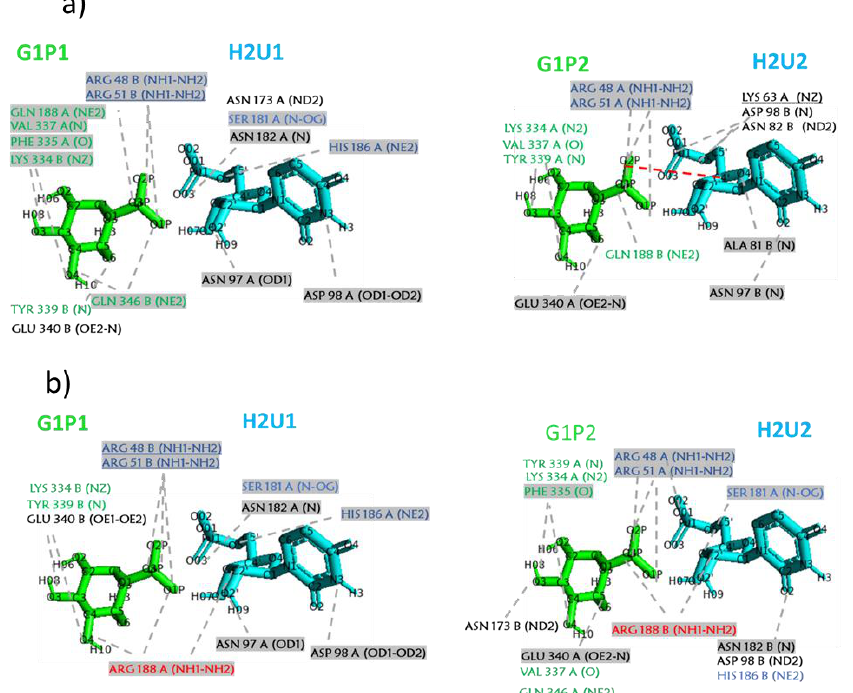
Figure 5. Interactions between enzyme and ligands in simulations at 334 K. ( a ) wtGALT; ( b ) p.Gln188Arg. Panels on the left indicate the ligands of the active site 1 (formally belonging to subunit A), panels on the right indicate the ligands of the active site 2 (formally belonging to subunit B). Grey background indicates interactions that persist for more than 50% of the simulation time. Grey dashed lines indicate H-bonds; residues underlined are also able to form salt bridges. Red dashed lines indicate interactions between the ligands.